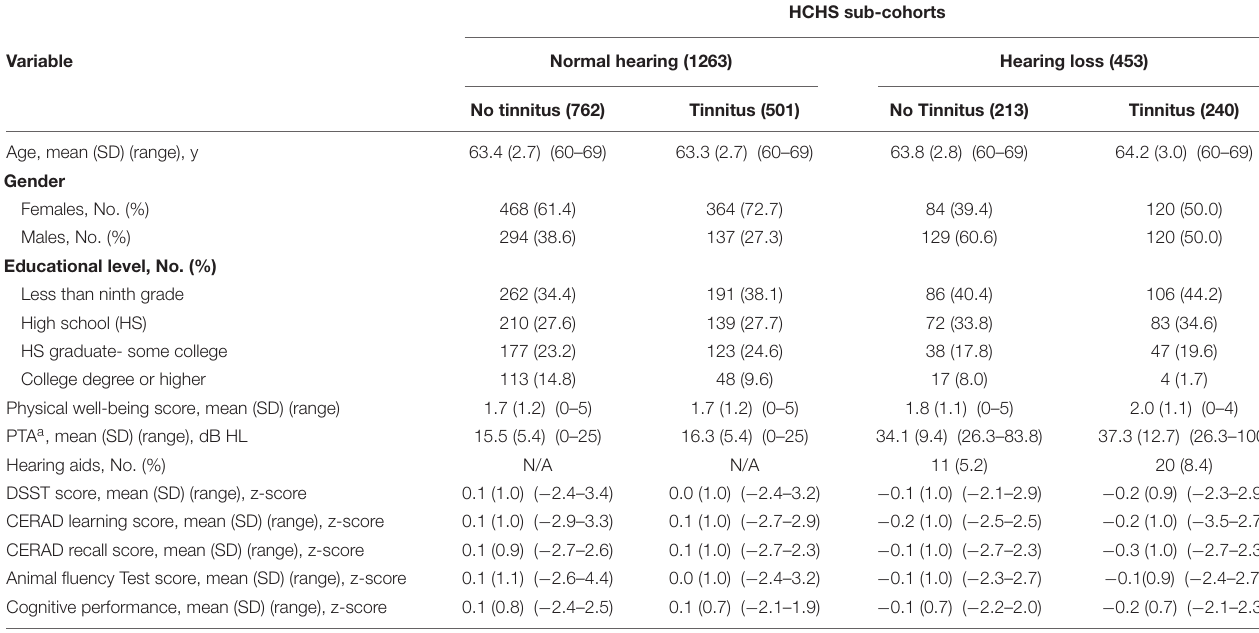
TABLE 3 | Participant characteristics and test scores of the HCHS